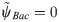
Sensitivity analysis for the factor difference in antibiotic potency against bound bacteria compared with free bacteria—4 weeks.The total number of bacteria and the numbers of free and bound bacteria at 4 weeks (672 hr), BT(672), BF(672) and BB(672) respectively, are plotted for a range of values of the potency factor, ω. Note the log2 scale on the x-axis. In all cases both BT(672) and BB(672) decrease monotonically with increasing ω, while BF(672) is monotone decreasing in Cases A–C and increases before decreasing in Case D. The effect is particularly pronounced in Case C, where the bacterial burden is almost eliminated (BT = O(10)) as ω approaches 2. Eqs 1–11 were solved using ode15s, with a constant antibiotic dose and without inhibitors. Parameter values: A = 8 μg ml−1, ψ˜Bac=0 hr−1, ψ˜I=0 hr−1, λ = 0 cm3cell−1hr−1 and ρ = 0 hr−1. See Tables 2–4 for the remaining parameter values.